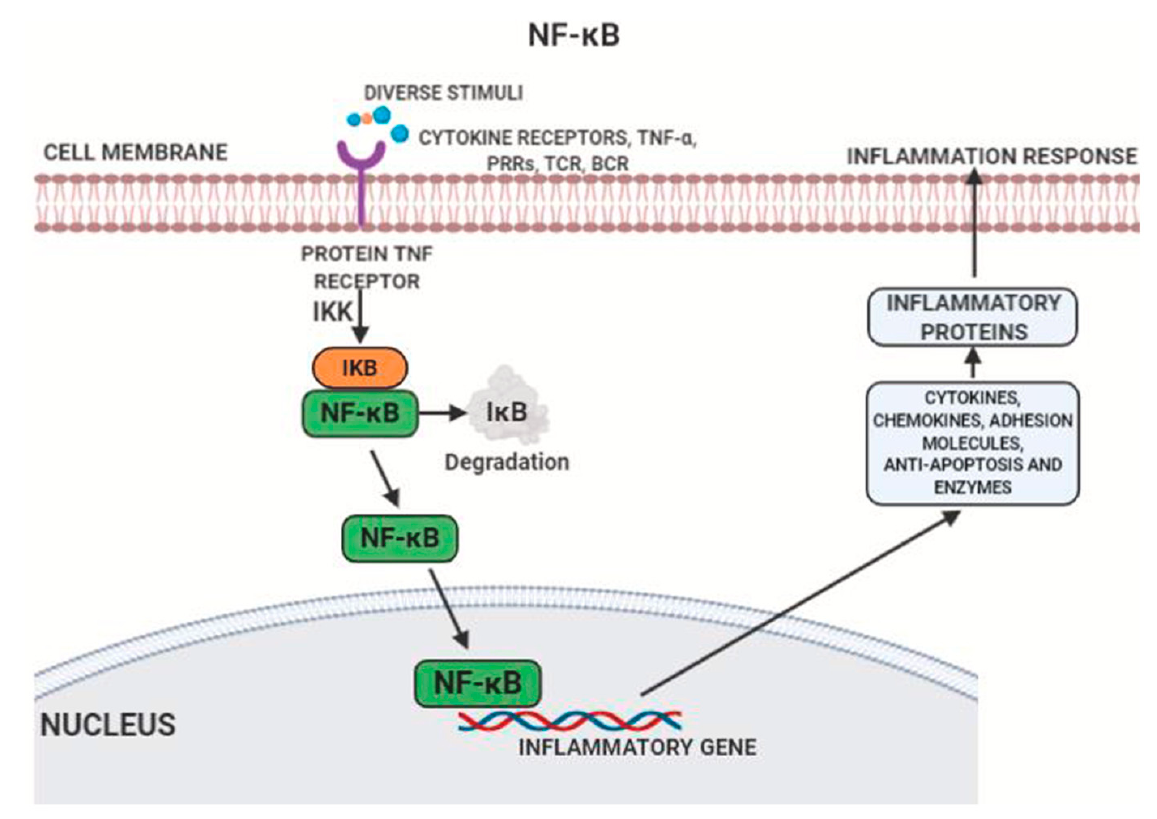
Figure 1. NF-kB signaling [20].